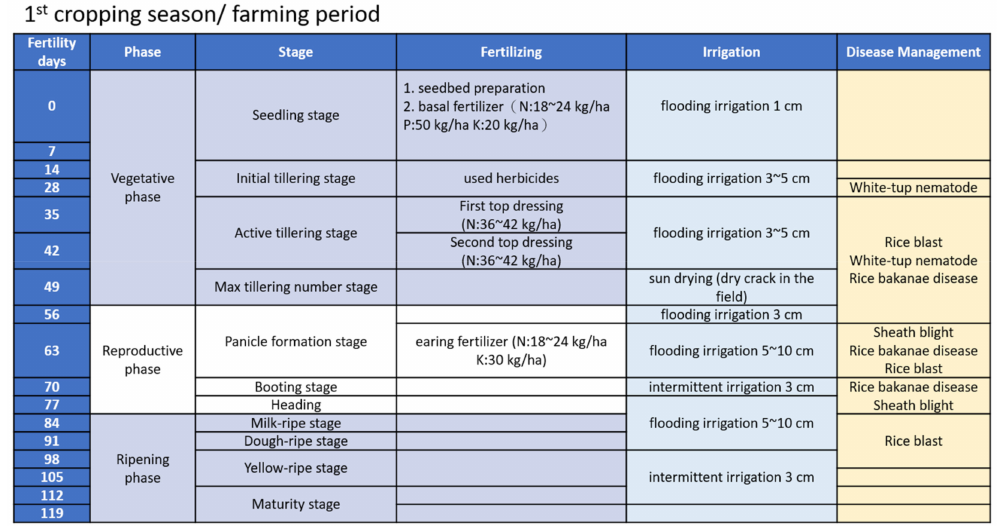
Figure 2. The First Rice Farming Period and Related